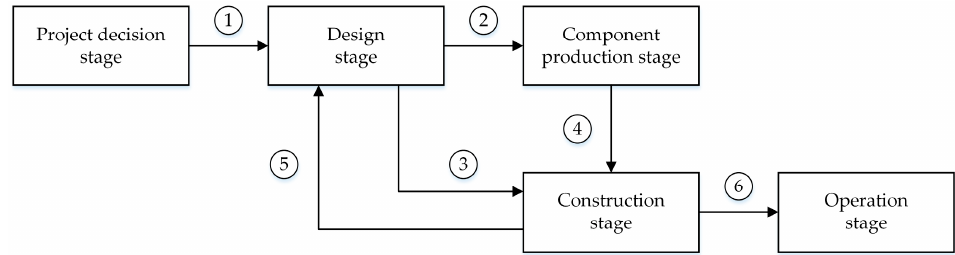
Figure 1. The logical relationship of each stage of prefabricated building.